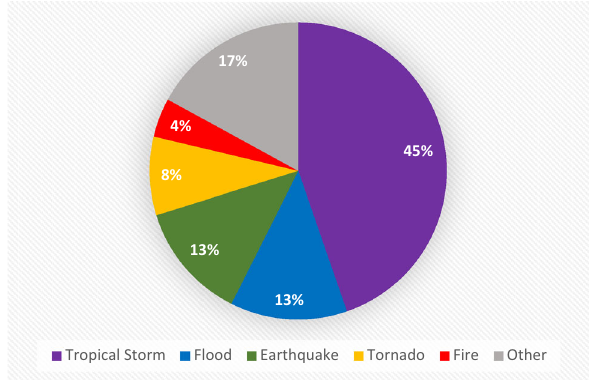
Fig. 2 Proportion of studies by hazard